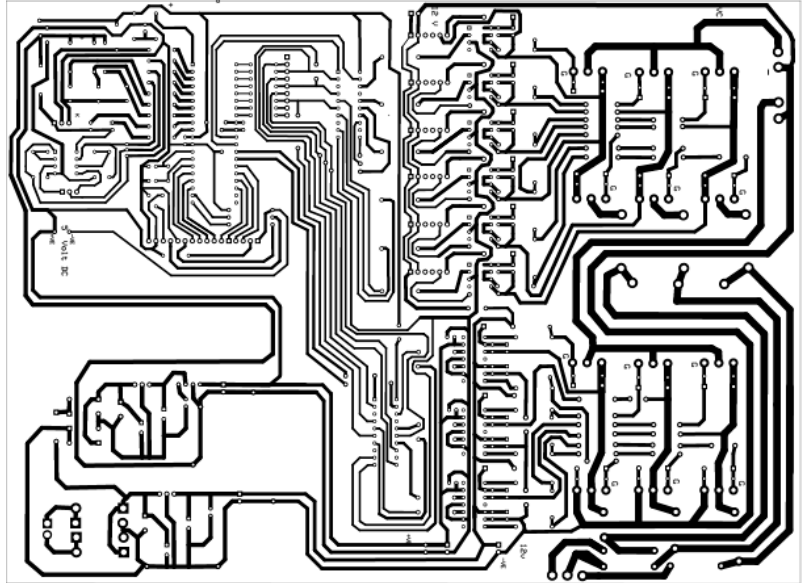
Figure 30. Hardware implementation.